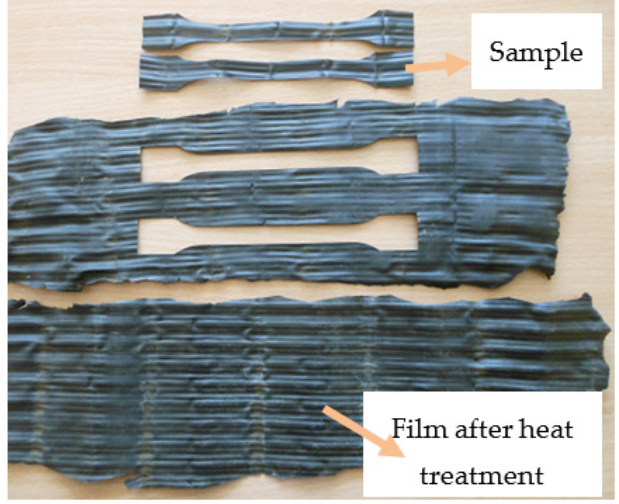
Figure 5. View of the straightened film